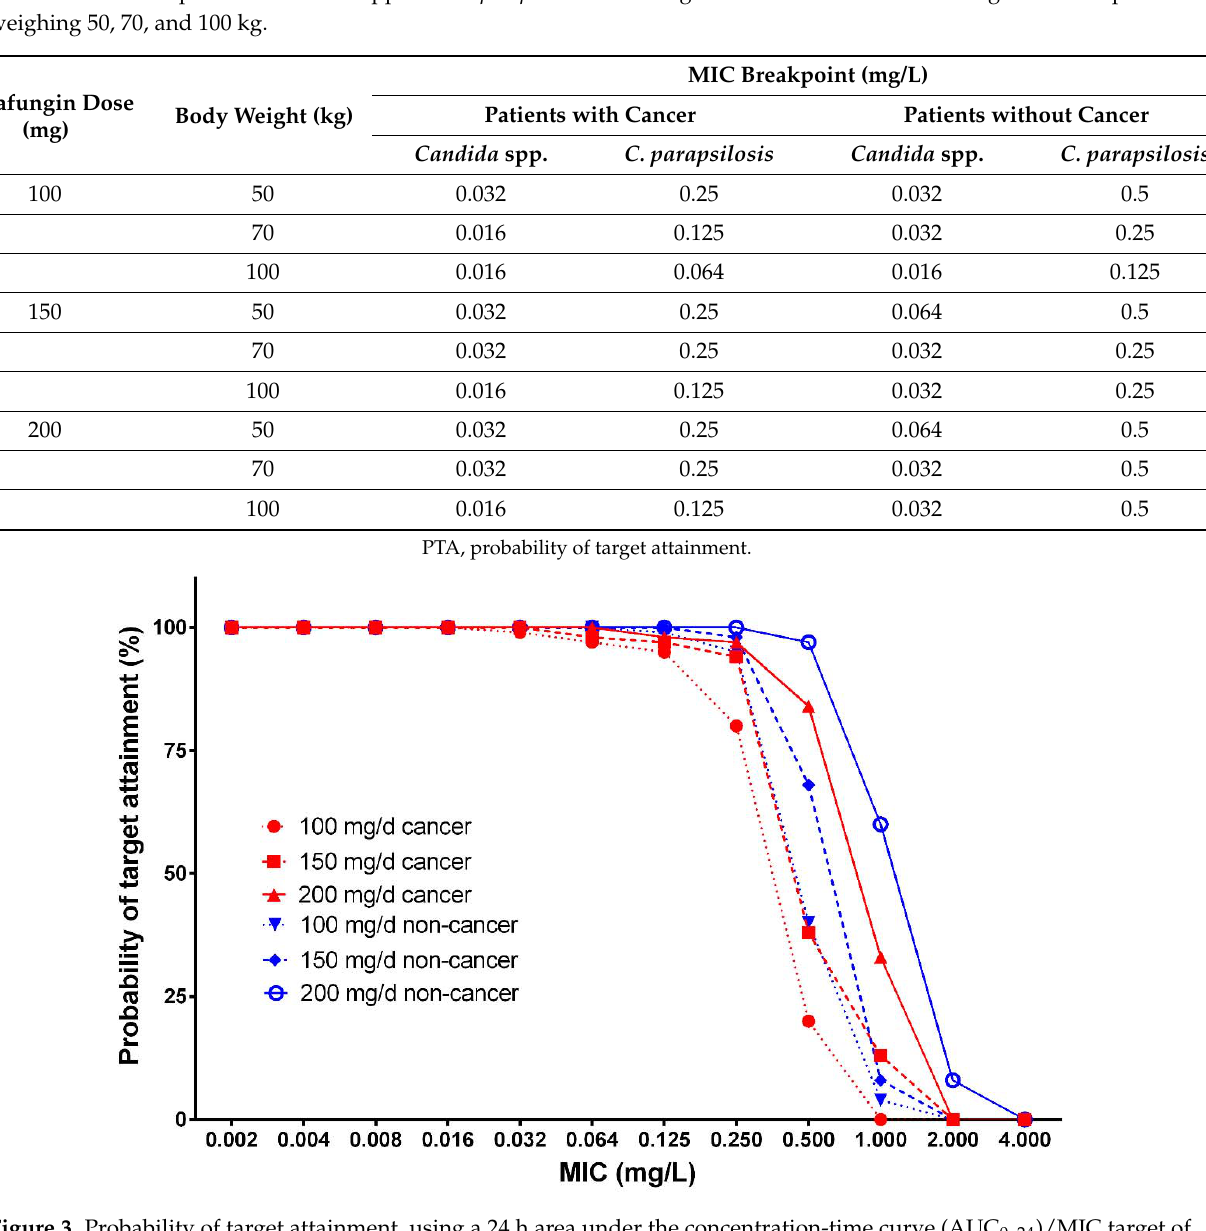
Figure 3. Probability of target attainment, using a 24 h area under the concentration-time curve (AUC 0–24 )/MIC target of 285 for Candida parapsilosis for different micafungin dosing regimens in patients with and without cancer.